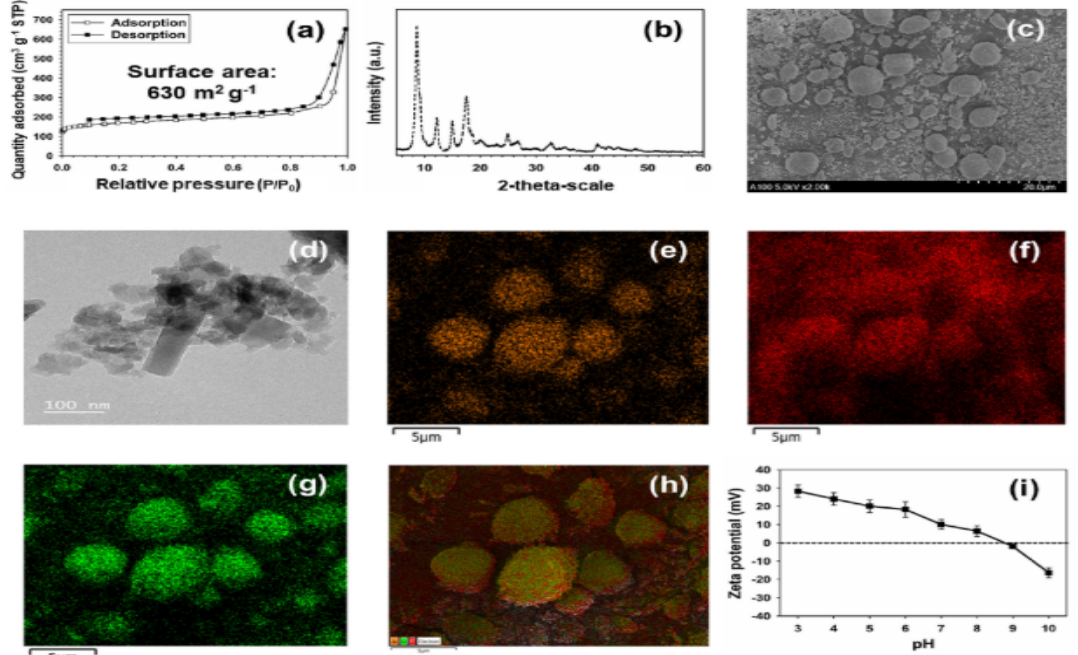
Figure 7. Characterizations of MOF using ( a ) BET, ( b ) PXRD, ( c ) SEM, ( d ) TEM, and ( e – h ) SEM-EDS for elemental mapping of Al, C, O, and total, respectively, and ( i ) zeta potential adapted with permission from [111].